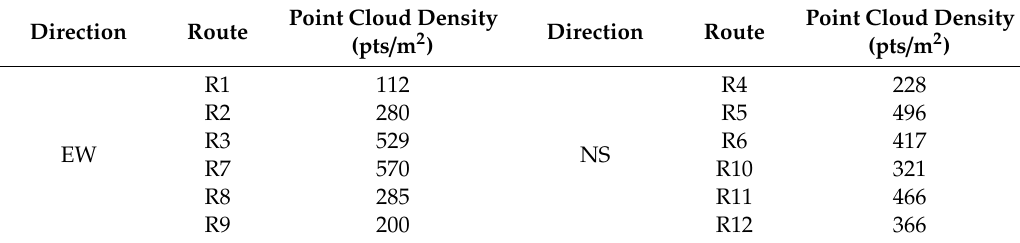
Table 1. LiDAR point cloud densities of the different routes.